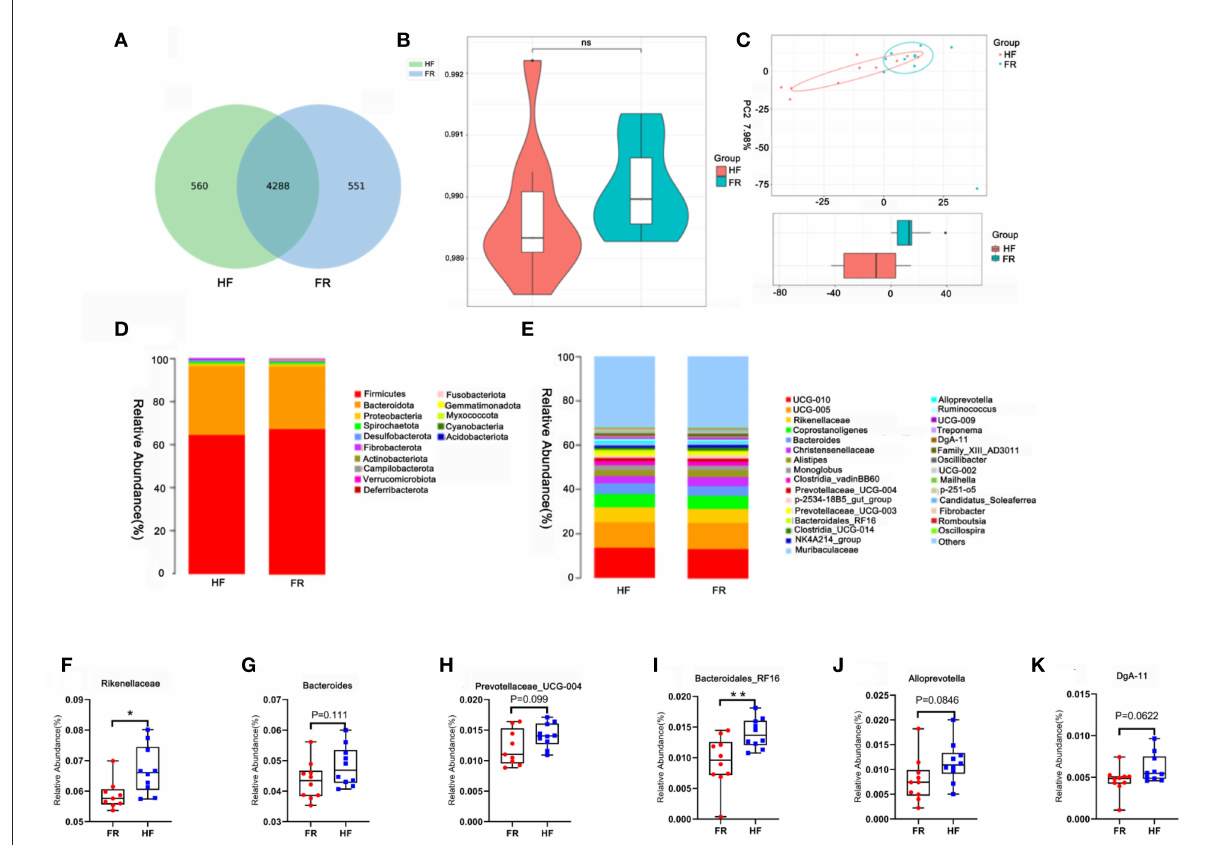
FIGURE6 House feeding modes improved yak gut microbiota. (A) The Wayne figures of fecal microbiota. (B) The Chao 1 index of fecal microbiota. (C) PC analysis of fecal microbiota at the OUT level. (D) Difference bacterial abundance at the phylum level. (E) The relative abundances of